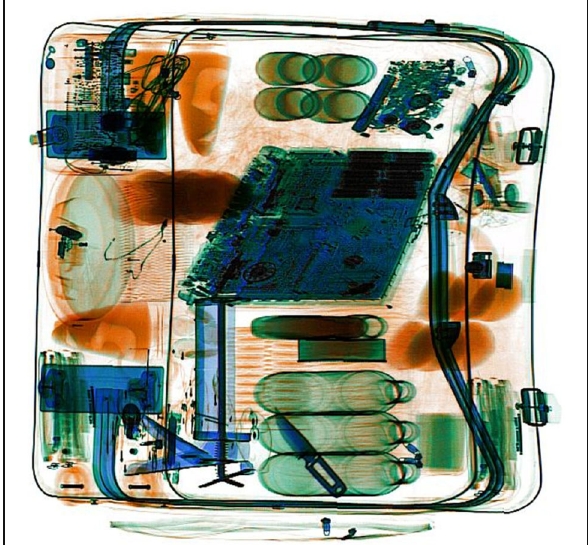
Fig. 1 Example of a target-present image. The knife is in the lower portion of the image, at